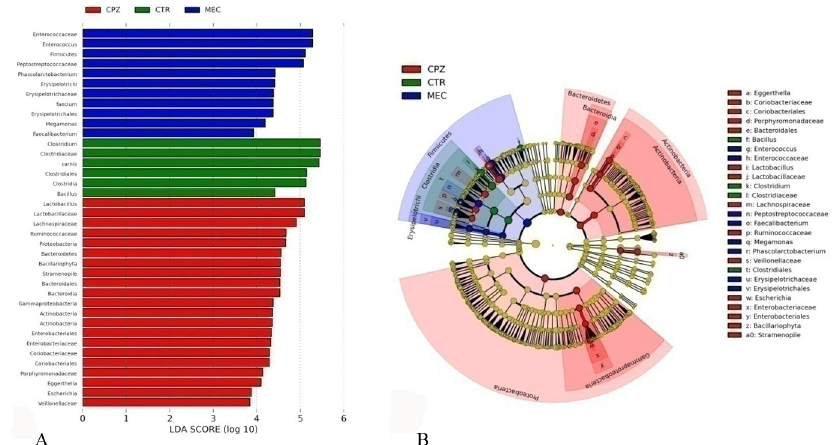
Fig 6. LEfSe statistic chart comparing β -lactams groups during antibiotic